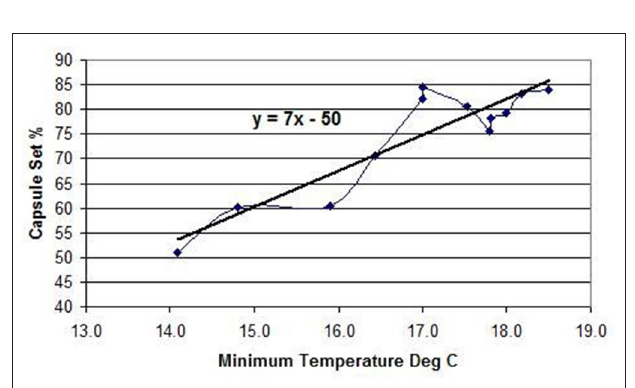
FIGURE 4 | Trend and influence of temperature (min) on cardamom capsule set